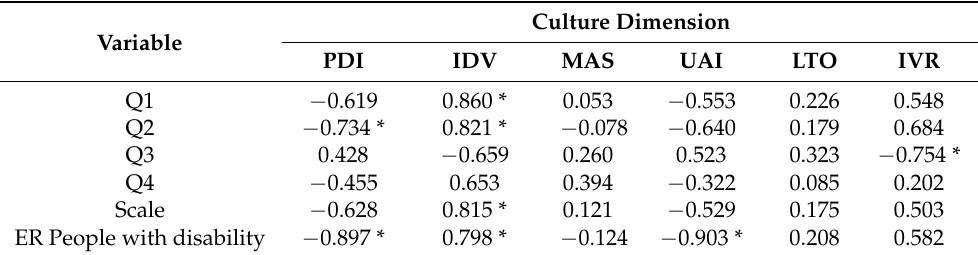
Table 1. Pearson’s correlation coefficients between culture dimensions according to Hofstede, ques- tions from the proprietary questionnaire and Eurostat data. Culture Dimension Variable PDI IDV MAS UAI LTO IVR Q1 − 0.619 0.860 * 0.053 − 0.553 0.226 0.548 Q2 − 0.734 * 0.821 * − 0.078 − 0.640 0.179 0.684 Q3 0.428 Scale − 0.628 0.815 * 0.121 − 0.529 0.175 0.503 ER People with disability − 0.897 * 0.798 * − 0.124 − 0.903 *